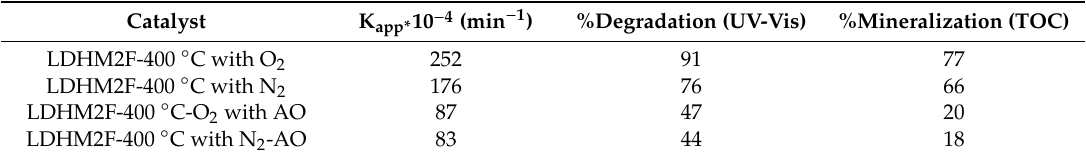
Table 3. Apparent kinetic constant, percentage of degradation, and percentage of mineralization of activated layered double